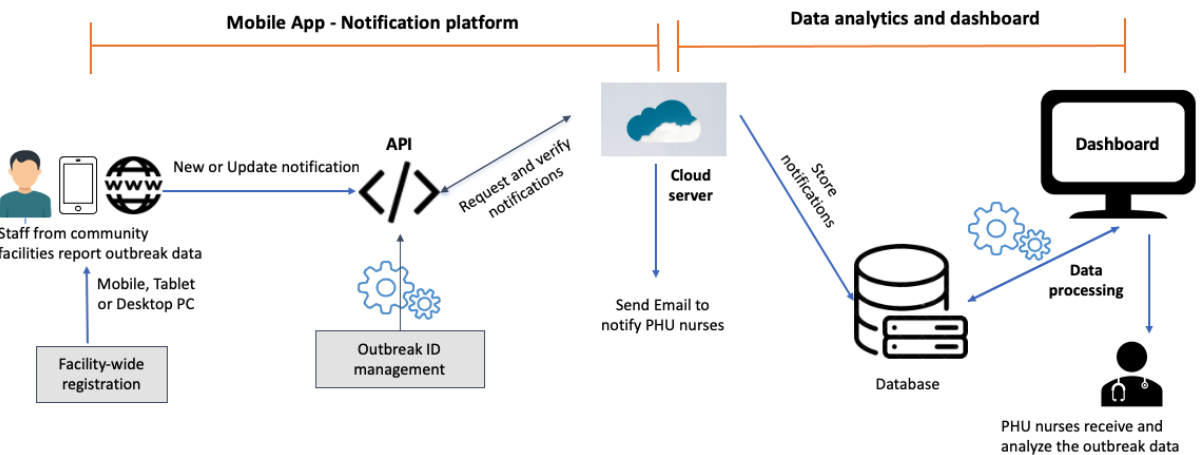
Figure 4. Overview of our proposed system. Data analysis and dashboard. API: application programming interface; PHU: public health unit.